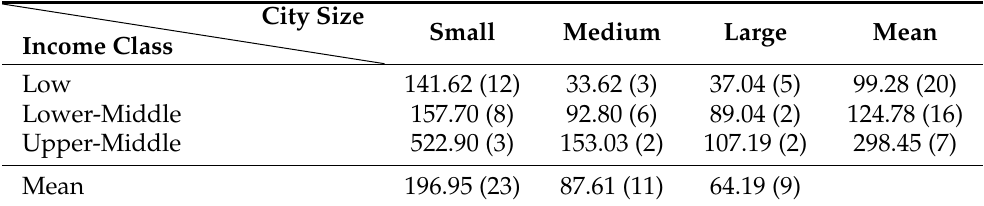
Figure 11. Relationship between population densities in built-up areas (people per km 2 ) and GDP per capita ($ per people) of the country in 2015. Table 4. Sprawl per new dweller (m 2 per people) between 2000 and 2015 depending on the size of the urban area and the country’s income class (in brackets the number of case studies). Income classes are from the WorldBank’s classification. Population size classes: small (less than 500,000 inh.), medium (between 500,000 and 1,000,000 inh.) and large (more than 1,000,000